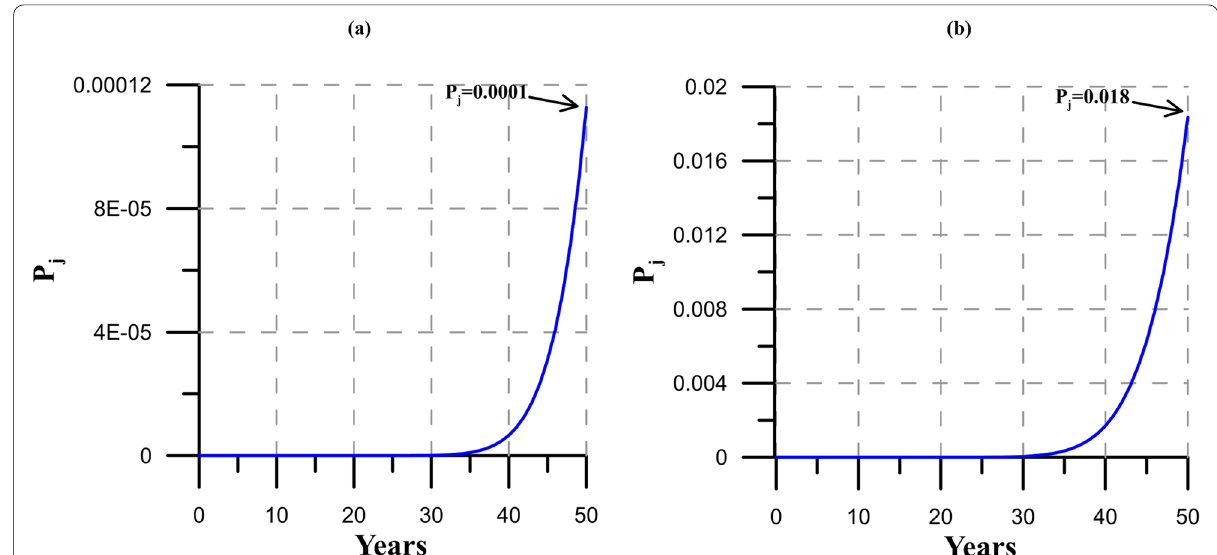
Fig. 6 Probability of exceeding the fatigue limit state over the lifetime of the bridge in section no. 43 obtained using traffic model from WIM system ( a ) and from Eurocode 1 ( b